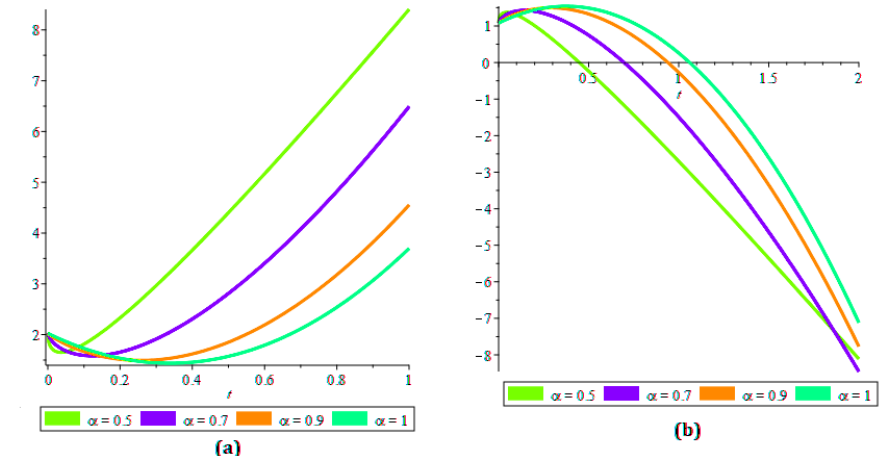
Figure 4. The analytical solution ( a ) u ( ϕ , ( τ )) and subplot ( b ) v ( ϕ , ( τ )) at A = 17 and y = 0.1, respectively, from Example